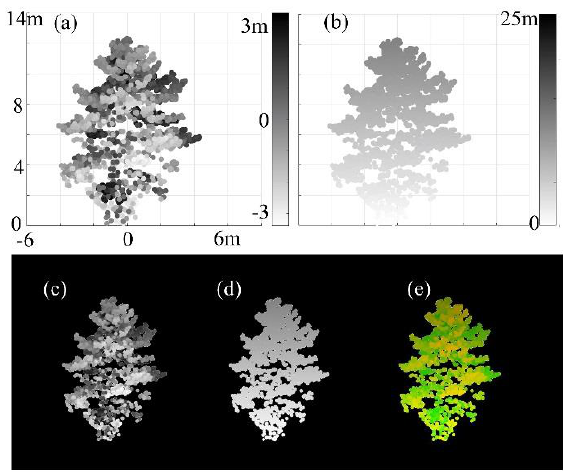
Figure 2. Example of a pine LiDAR tree projected on to x-z plane (a) shows the results when the origin represents the x-y Figure 1. Example LiDAR segmented tree crown, the top row centroid of the tree, the lowest point of the recorded LiDAR shows five examples of pine trees, the middle row shows five point is zero. Grey value represents the location of the LiDAR examples of maple trees and the bottom row shows five point out of the paper (+) and into the paper (-) (b) shows the examples of poplar trees, the greyscale of the points represents results of the same tree on the same axes where grey scale UTM northing (m). represents height above the lowest recorded LiDAR point. (c) and (d) are the resulted image produced from (a) and (b), respectively. (e) is the result of combining (c) and (d) into a 2- channel image where (c) represents red channel and (d) represents green channel.